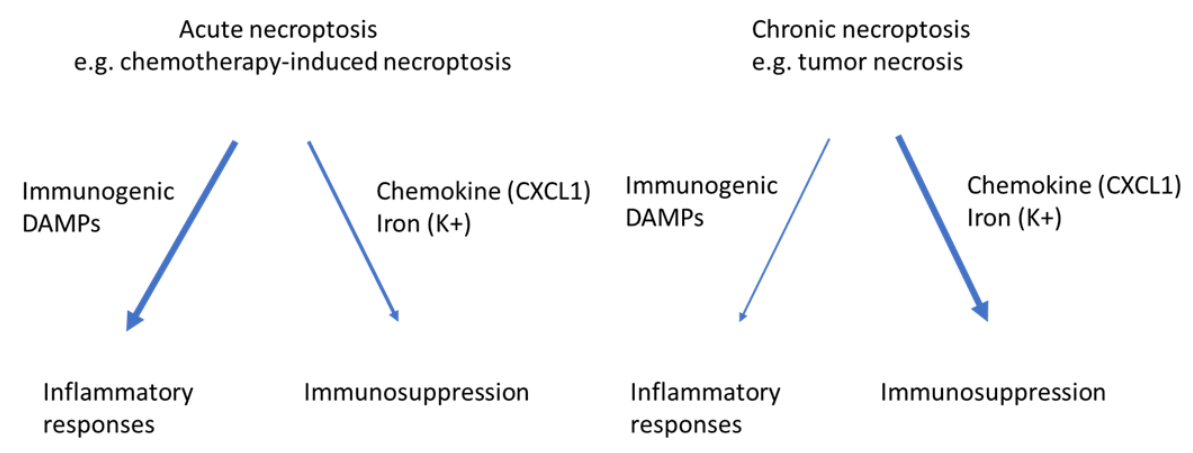
FIGURE 2: Necroptosis of tumor cells can have immunogenetic or immunosuppressive effect on tumor immunity. While acute necroptosis is more immunogenetic and favors anti-tumor immunoactivity, chronic necroptosis promotes pro-tumor immunity through releasing immuno- suppressive factors such as CXCL1 and K +